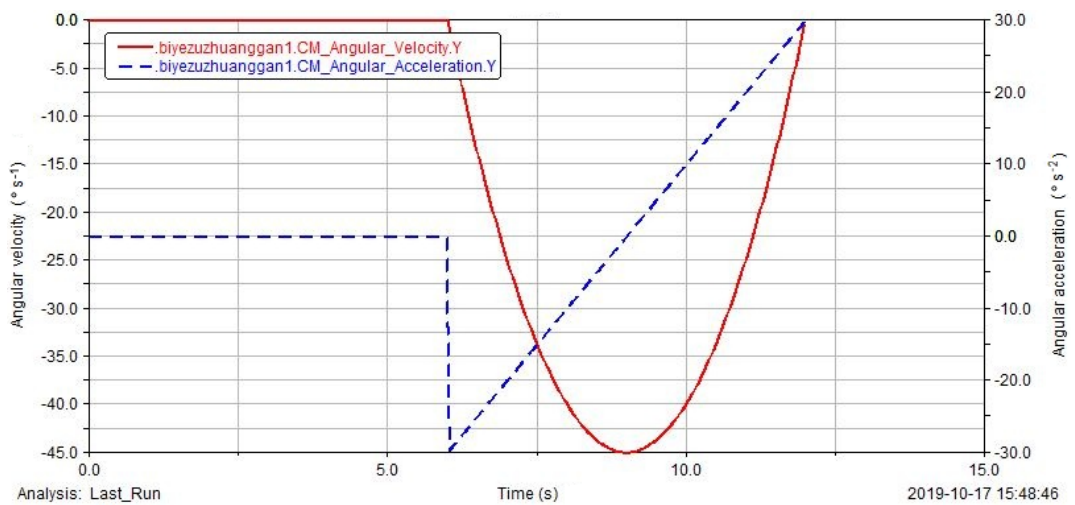
Figure 20. Robot assembly motion simulation